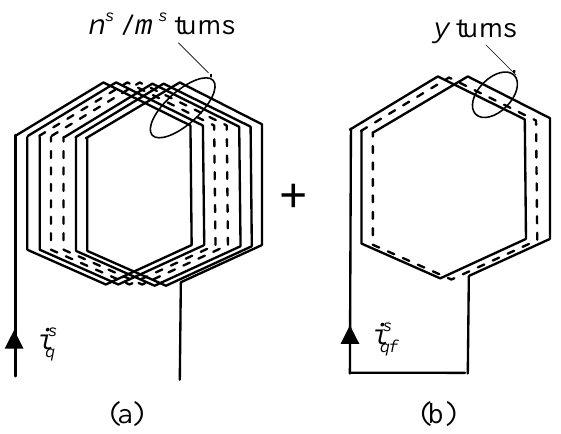
Figure 5. Modeling of an elementary coil with y short-circuited turns: (a) healthy elementary coil; (b) additional coil.